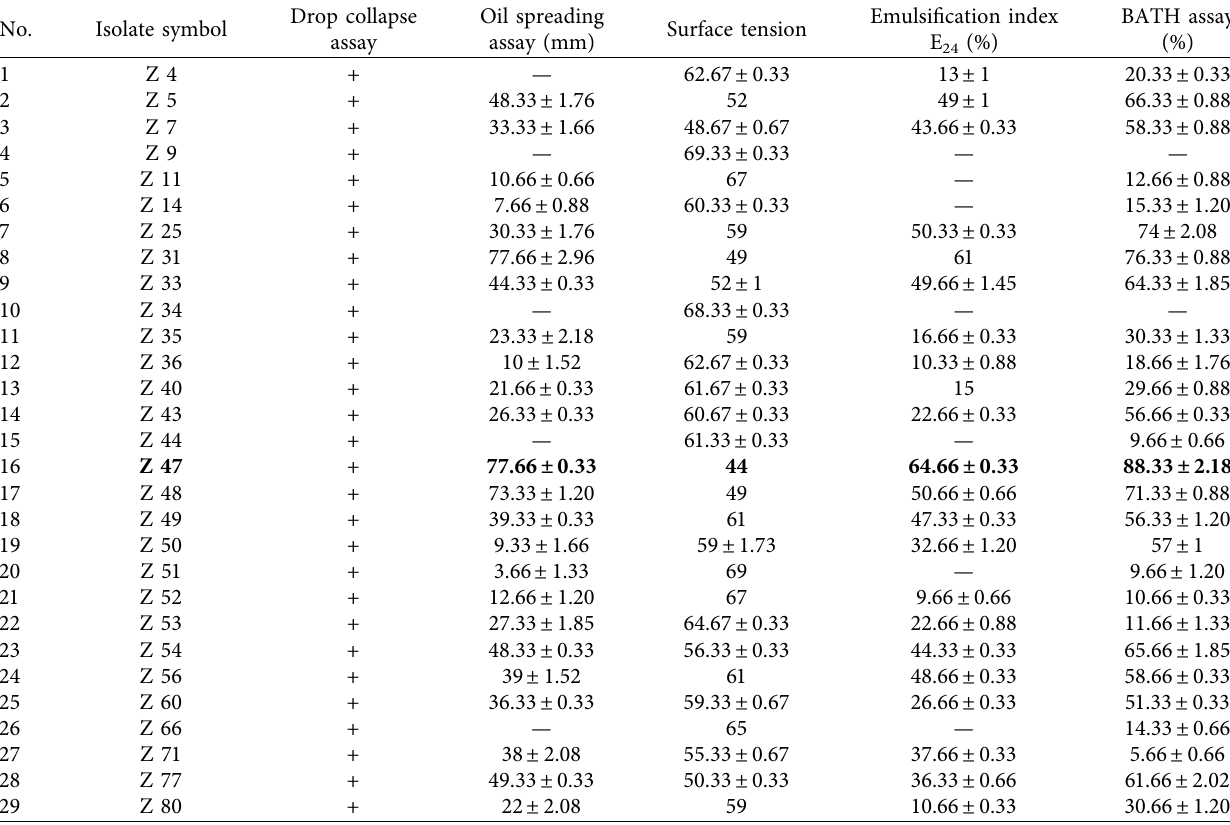
Table 2: Secondary screening of bacterial isolates for biosurfactant